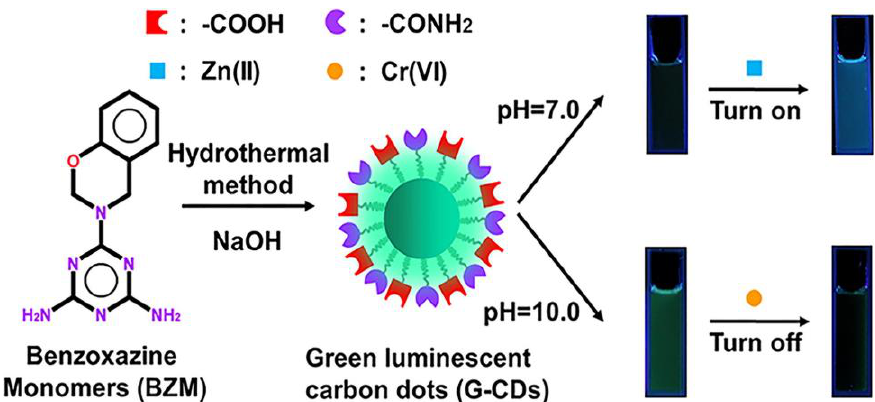
Figure 51. Graphical representation of pH-controlled green luminescent carbon dots with fluores- cence turn-on and turn-off detection (reproduced from the work in [41] with permission).